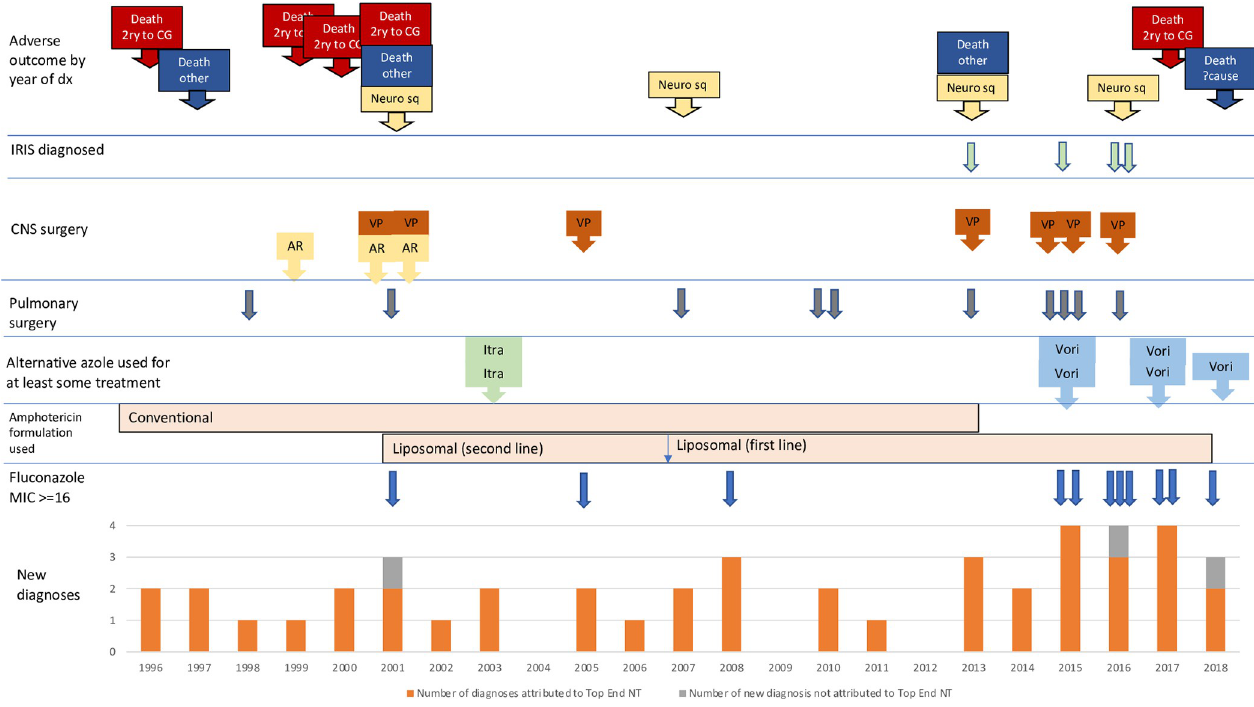
Fig 3. Timeline. New diagnoses, management and outcomes of patients infected with C . gattii managed at RDH over the 22 years of the study. Death 2ry to CG Death attributed to C . gattii Death Other Death within 12 months or before completion of treatment attributed to other cause Neuro sq Infection cured with significant neurological sequelae IRIS immune reconstitution syndrome CNS central nervous system VP VP shunt inserted AR Access reservoir inserted Itra itraconazole Vori voriconazole.